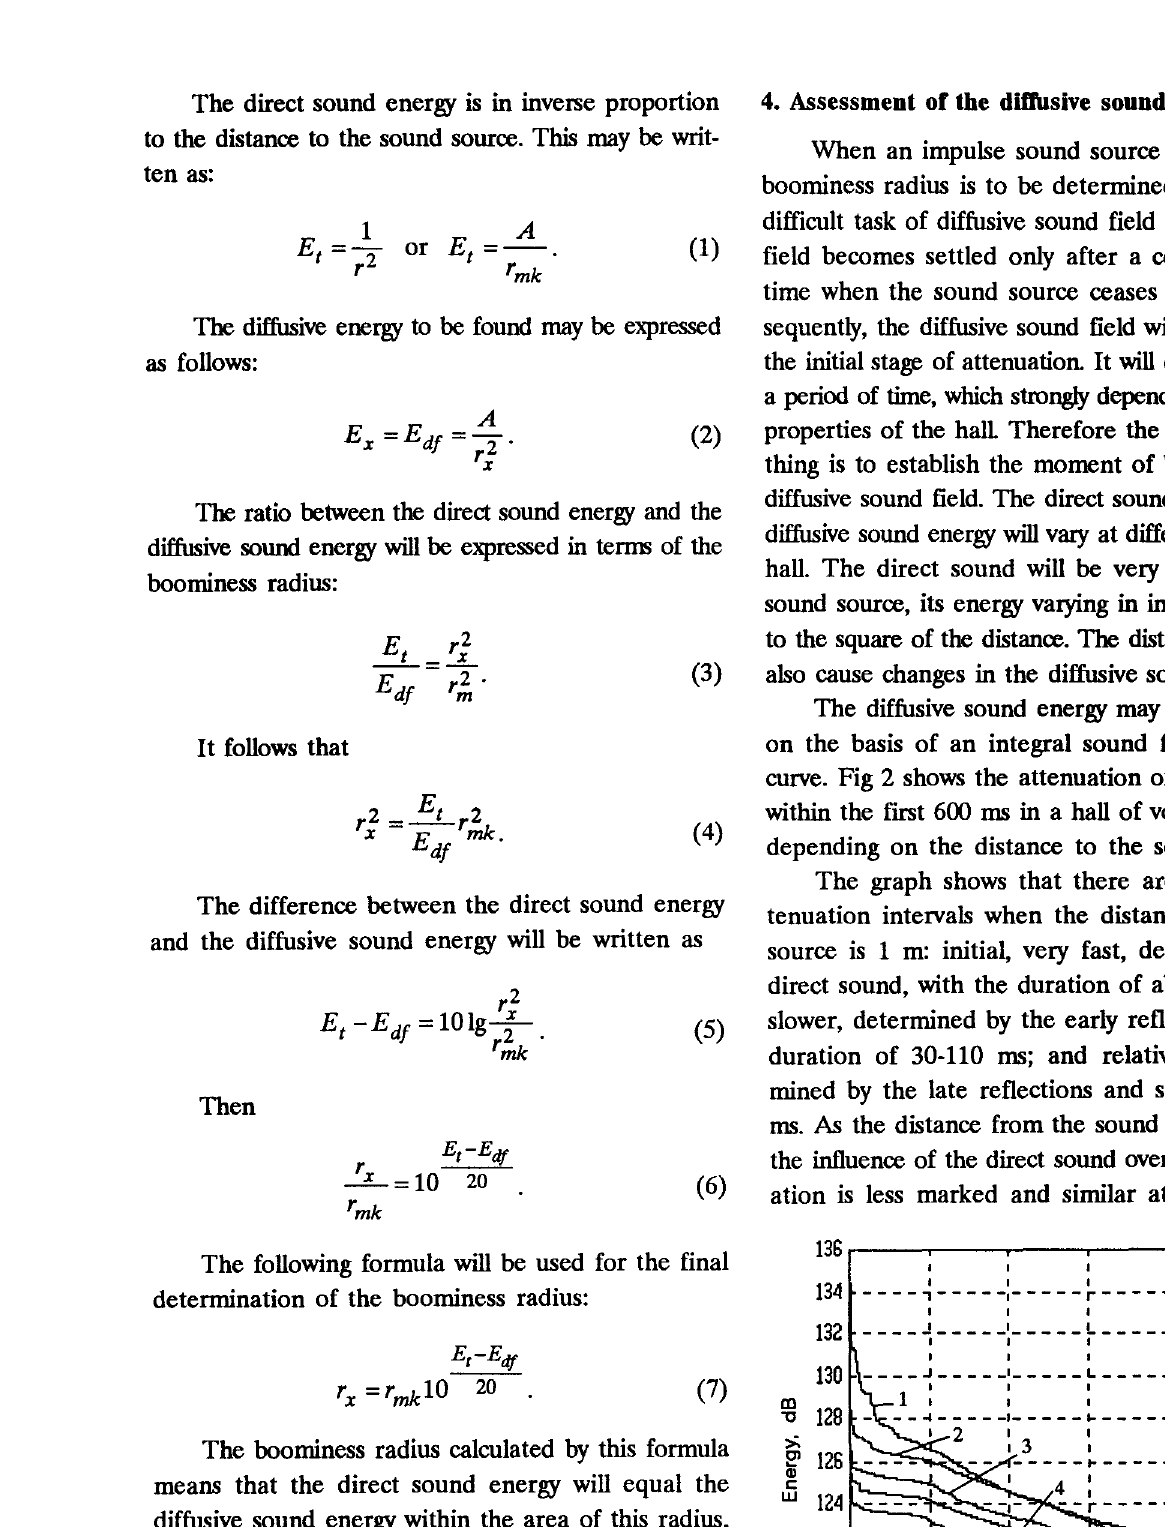
Fig 2. The attenuation of the sound energy in the hall depending on the sound source distance. 1 - 1 m; 2 - 2.5 m; 3 - 5 m; 5 - 10